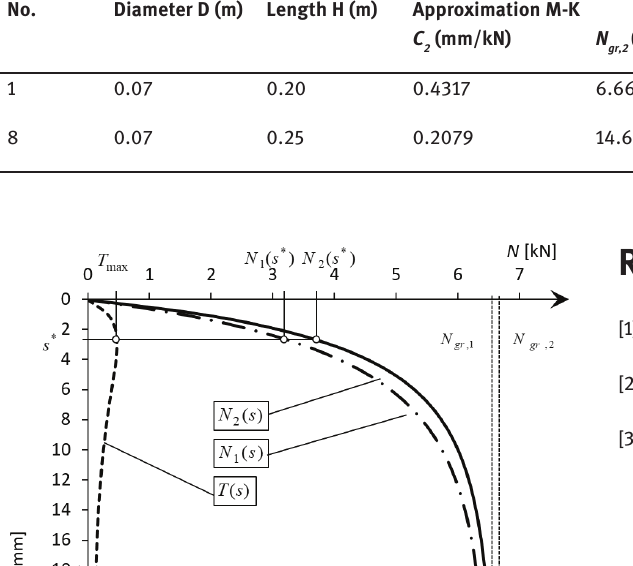
Table 2: Comparison of the M-K approximation of piles 1 and 8 in experiments. No.